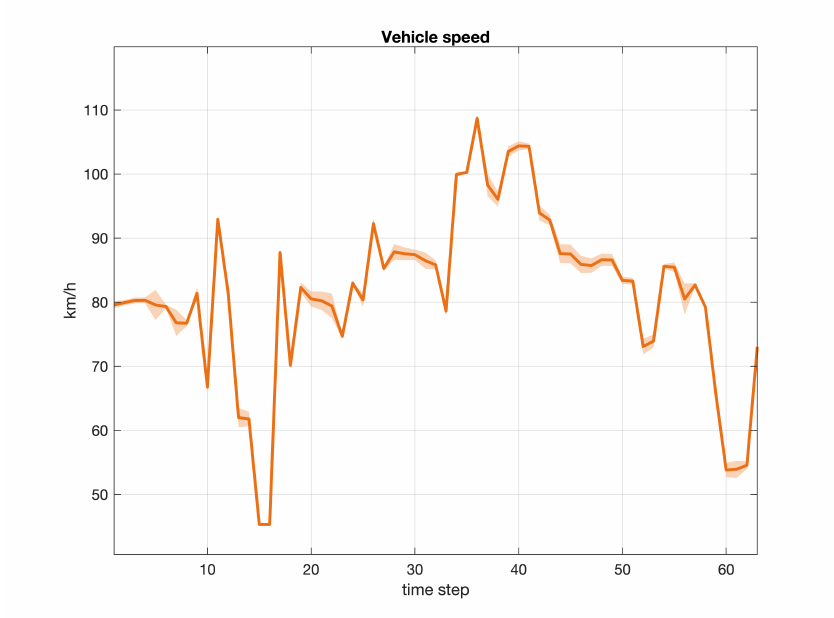
Figure 7. Vehicle speed (label 2). Average value (continued bold line) and 3-sigma area plot for 203 samples.